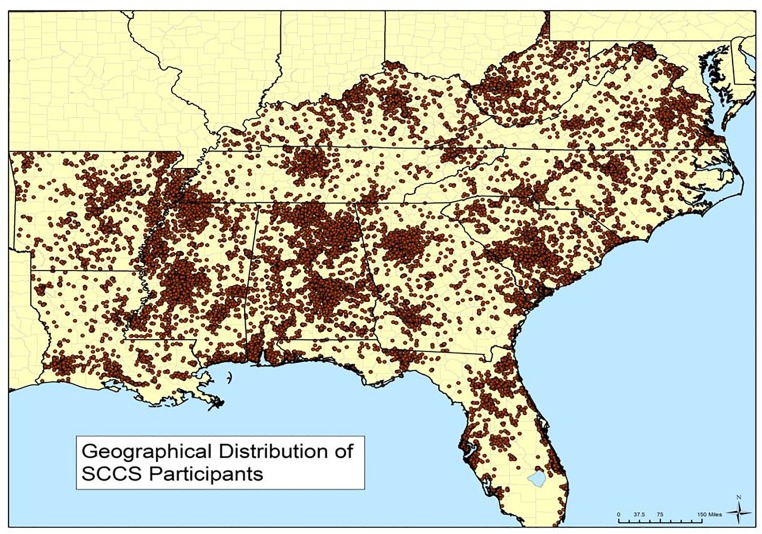
Geographical distribution of SCCS participants.